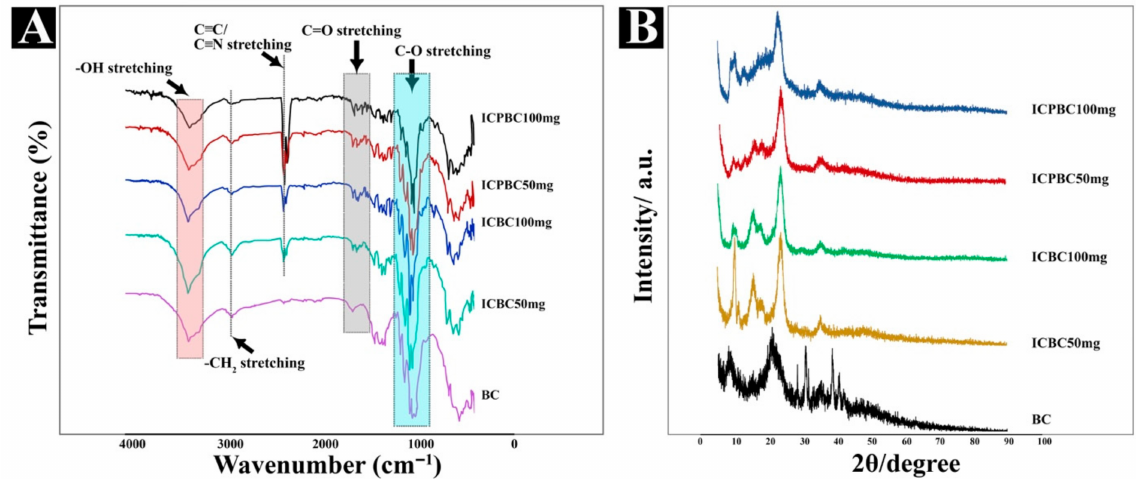
Figure 3. ( A ) FT-IR spectra of drug-loaded fibrous membranes and raw material. ( B ) XRD patterns of drug-loaded fibrous membranes and raw